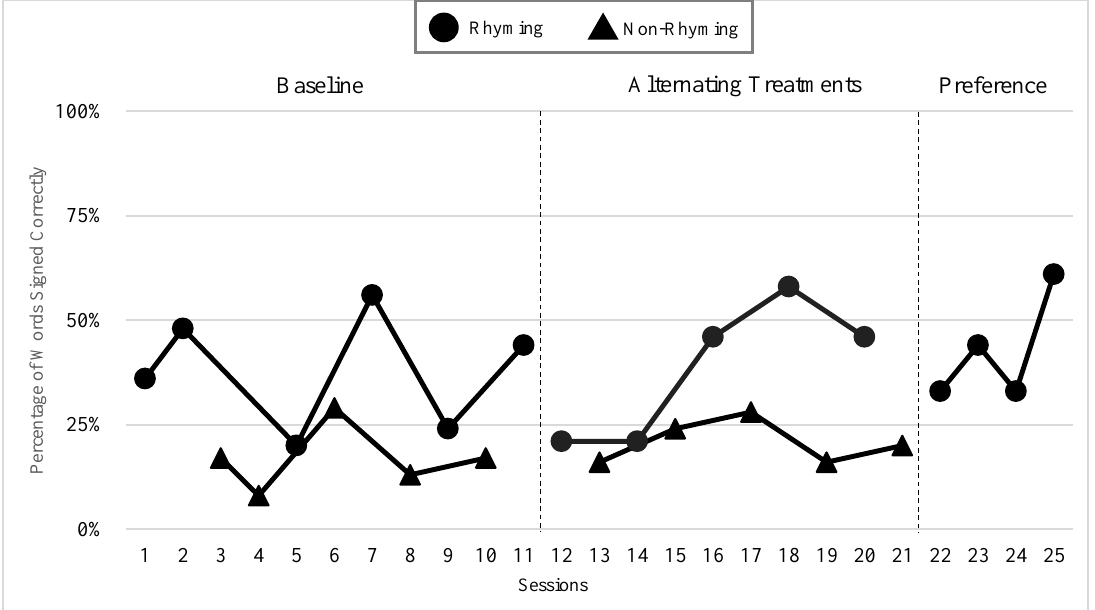
Figure 15. Lexie’s Percentage of Words Signed Correctly in Recitation.